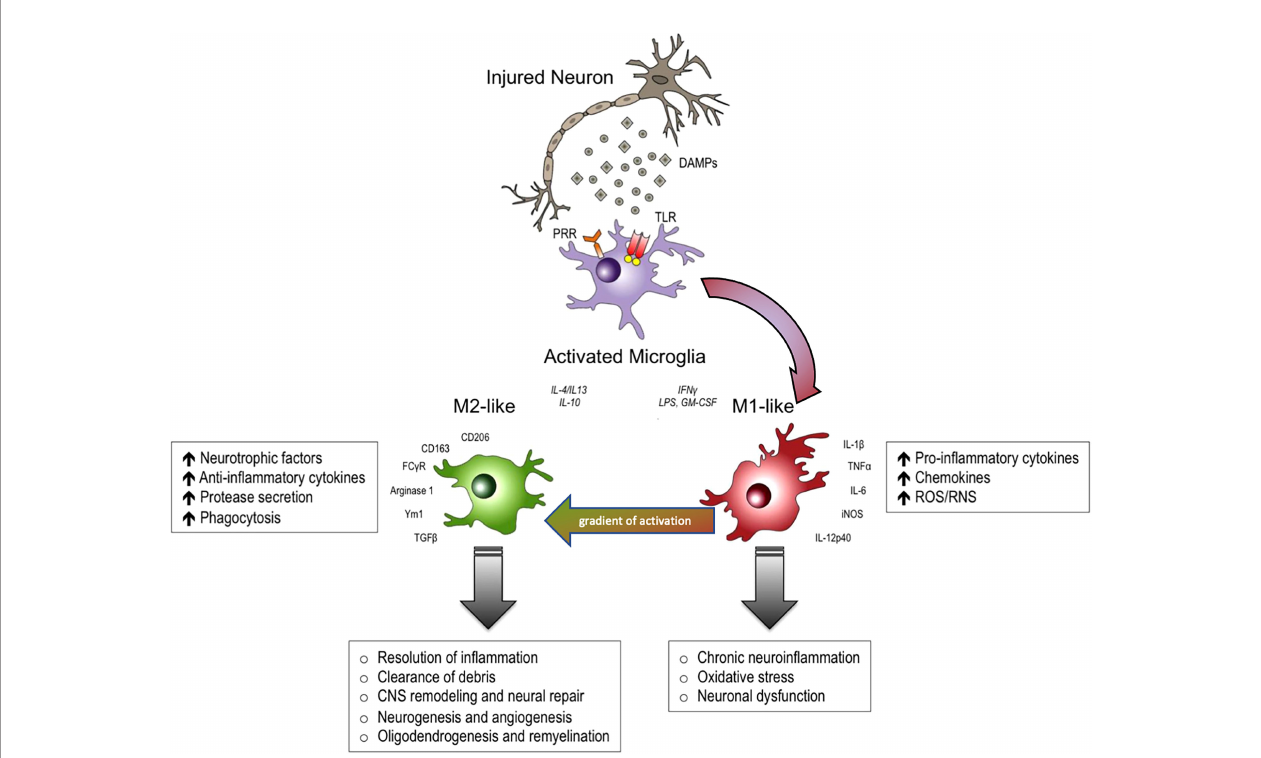
FIGURE 1 | In response to danger-associated molecular patterns (DAMPs), and other extracellular signals released by injured neurons, microglia can become polarized towards pro-in fl ammatory M1-like and anti-in fl ammatory M2-like activation states that can have distinct roles in neurodegeneration and tissue repair. M1- like microglia release pro-in fl ammatory cytokines, chemokines and free radicals that impair brain repair and contribute to chronic neuroin fl ammation, oxidative stress and long-term neurological impairments. M2-like microglia release anti-in fl ammatory cytokines, neurotrophic factors and proteases, and they have increased phagocytic activity. M2-like microglia promote immunosuppression and resolution of M1mediated neuroin fl ammation, and participate in CNS remodeling and repair by modulating neurorestorative processes such as neurogenesis, angiogenesis, oligodendrogenesis and remyelineation. However, there is much overlap between and M1 and M2 like cellular responses. DAMPs, danger-associated molecular patterns; PRR, pathogen recognition receptors; TLR, toll-like receptors. Modi fi ed from (1). Reproduced with